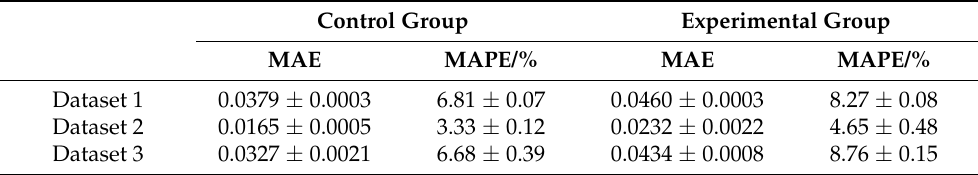
Table 7. The prediction comparison table of differential processing of input variables.